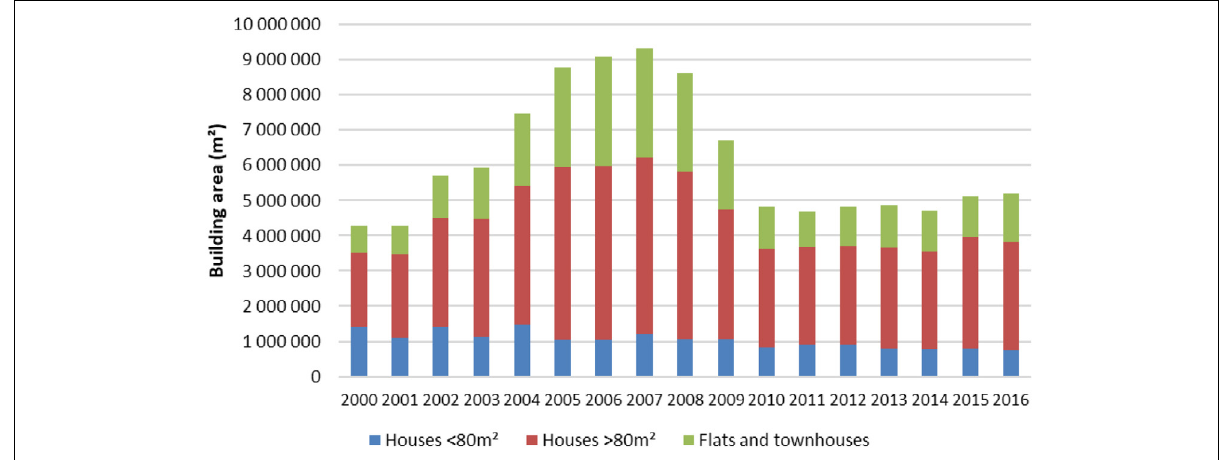
Figure 1: South Africa’s completed residential building area.